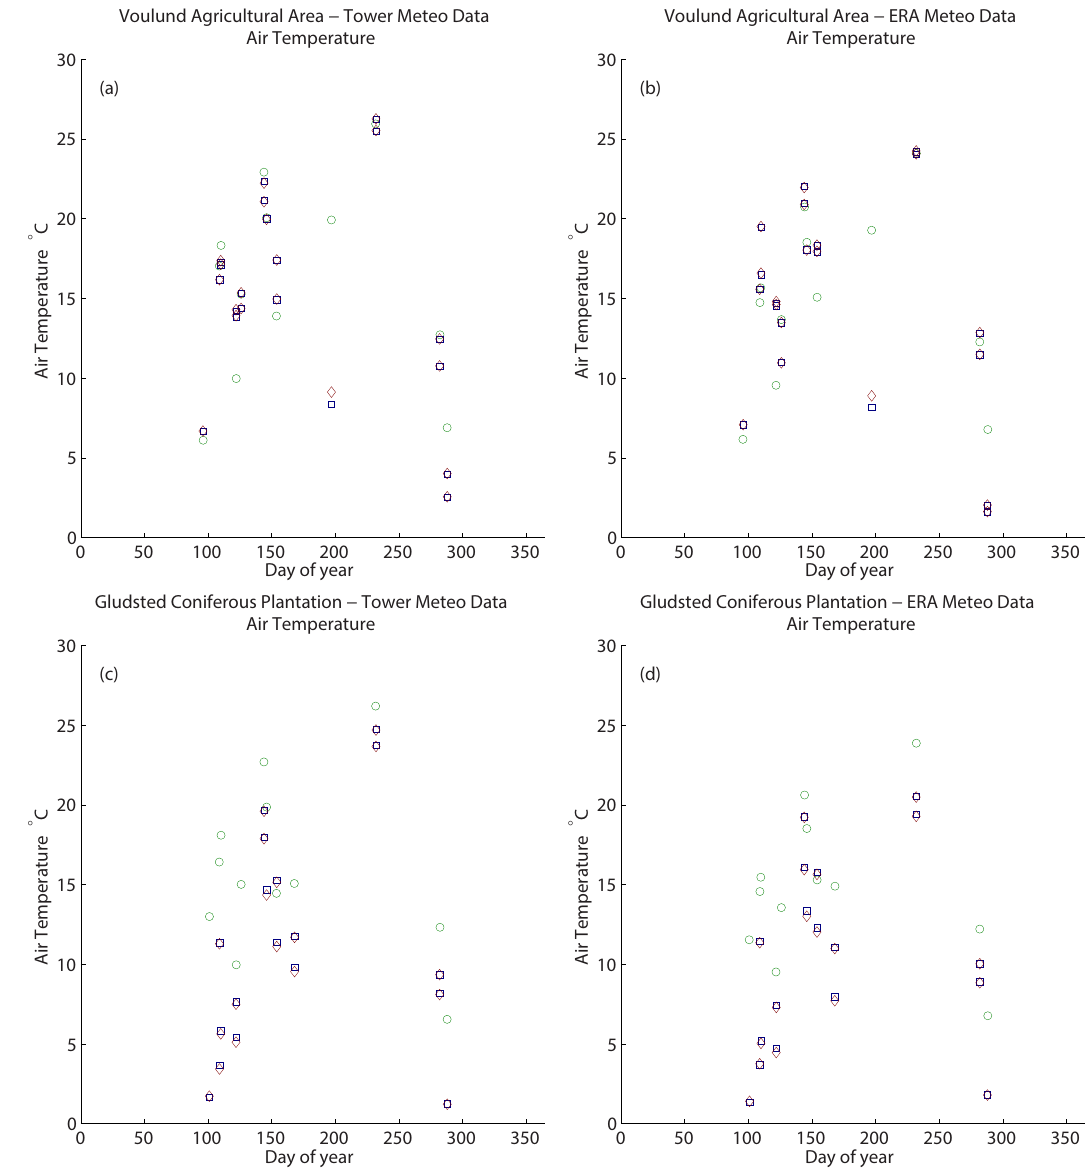
Figure 12. Temporal distribution of air temperature estimates at three stages of the disaggregation procedure with EF used as CR: initial value (green circles), value after disaggregation (blue squares), and value after smoothing (red diamonds). The air temperature is the mean of the estimates falling within the flux tower footprint. The panels on the left are with model runs using tower-based meteorological observations, and those on the right are with model runs using ERA-Interim-based meteorological inputs with the exception of incoming short-wave radiation which came from tower